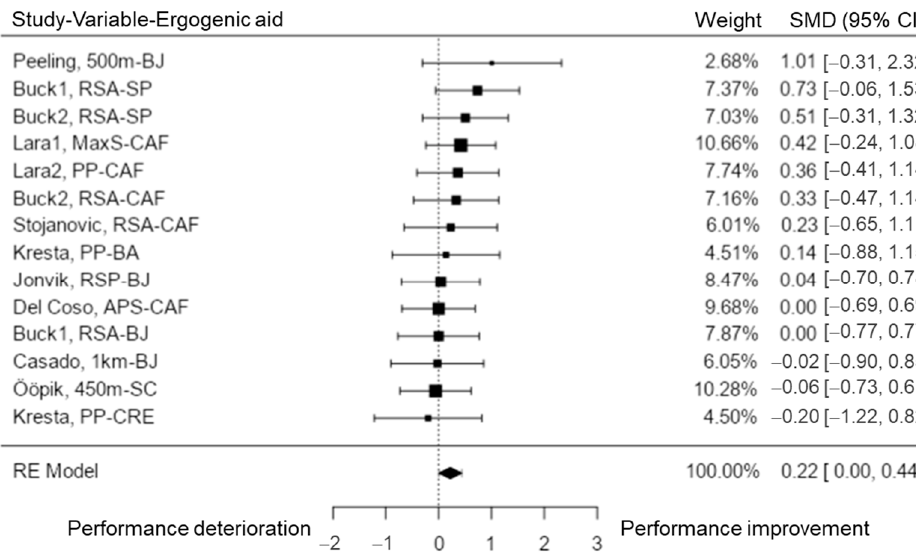
Figure 7. Anaerobic performance forest plot. RSA = repeated sprint ability; MaxS = maximal speed; PP = peak power; RSP = repeated sprint performance; APS = average peak speed.